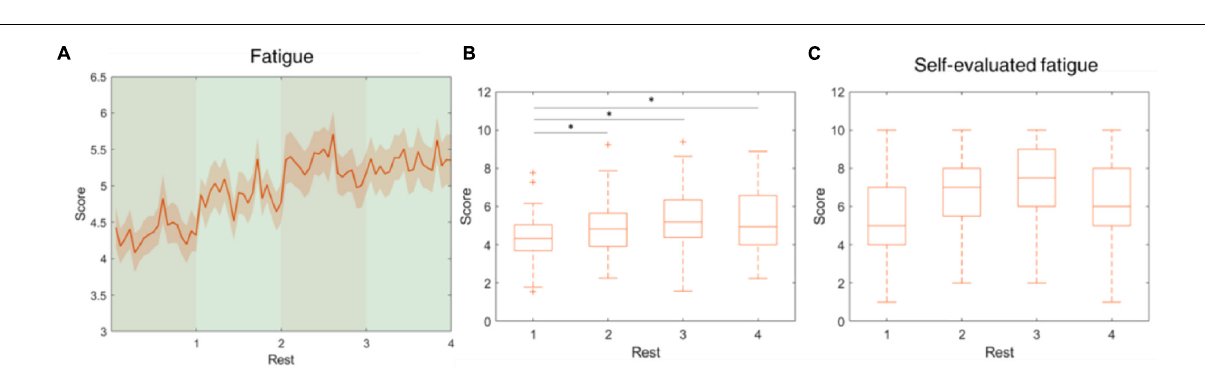
FIGURE 6 | Fatigue level fluctuations during the rest periods. This parameter was developed using theta, alpha and beta-band power at O1, Oz, and O2. (A) The average fatigue level across the four rest periods. (B) The fatigue level increased from rest 1 to rest 3 and mitigated in rest 4. (C) The self-evaluated fatigue level over four rest periods. *indicates that the difference between the two groups was statistically significant. The whiskers extend to the most extreme data points not considered outliers, and the outliers are plotted individually using the “+” marker